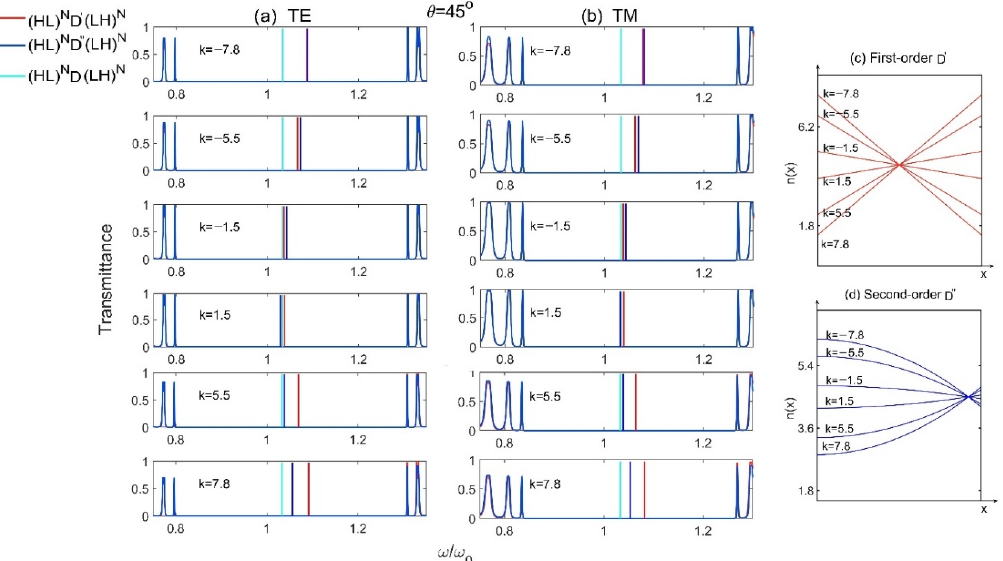
Figure 9. The transmission spectra of Model 5 (𝐻𝐿) (cid:3015) 𝐷 (cid:4593) (𝐿𝐻) (cid:3015) , Model 6 (𝐻𝐿) (cid:3015) 𝐷 (cid:4593)(cid:4593) (𝐿𝐻) (cid:3015) and the reference Model (𝐻𝐿) (cid:3015) 𝐷(𝐿𝐻) (cid:3015) for different incident angles at slope 𝑘 = 7.8 of the gradient defects higher than that for the reference model ( HL ) N D ( LH ) N at θ = 0 ◦ , 5.64% and 2.21% higher for ( a ) TE and ( b ) TM polarizations. at θ = 45 ◦ , and 6.08% and 2.51% higher at θ = 60 ◦ ; for TM wave the frequencies of defect modes are 4.79% and 1.69% higher at θ = 0 ◦ , 4.48% and 1.69% higher at θ = 45 ◦ , and Furthermore, the transmission spectra and the refractive index distributions for dif- 4.25% and 1.65% higher at θ = 60 ◦ . With the increase of incident angle, the defect modes ferent slopes 𝑘 are plotted as shown in Figure 10, where all the parameters are the same for both Model 5 and Model 6 shift faster to the high-frequency region than that in the as those in Figure 9. We can find that, no matter for TE or TM waves, the frequencies of reference model. It should be pointed out that all of our comparisons are obtained under defect modes decrease with the decrease of the absolute value of 𝑘 . And the changes of defect modes are asymmetrical with respect to the value of 𝑘 since the changes of refrac- the condition of keeping the average refractive indexes of the gradient defects in 1D GPCs tive index for the gradient defects are not symmetrical with the change of 𝑘 as shown in the same as the index of the corresponding normal material defect in the 1D NPCs (the Figure 10c,d. reference Model).